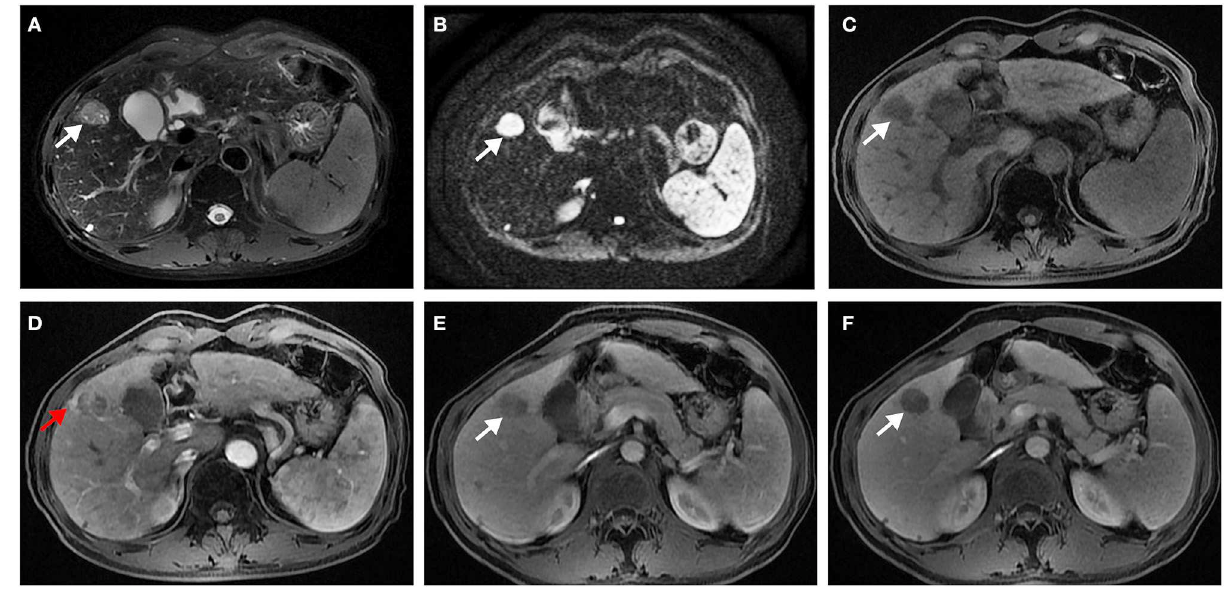
FIGURE 3 | Surgically confirmed moderately differentiated HCC with AFP = 245ng/mL. MR imaging showed a hepatic nodule (2.6cm, arrow) in S4 with mild-moderate T2 hyperintensity (A) and restricted diffusion (B) . The nodule is hypointense on precontrast T1WI (C) and shows corona enhancement (red arrow) in late arterial phase (D) , and washout appearance on portal venous (E), and delayed (F) phase. Histology confirmed MVI ( + ). This patient recurred 10 months after